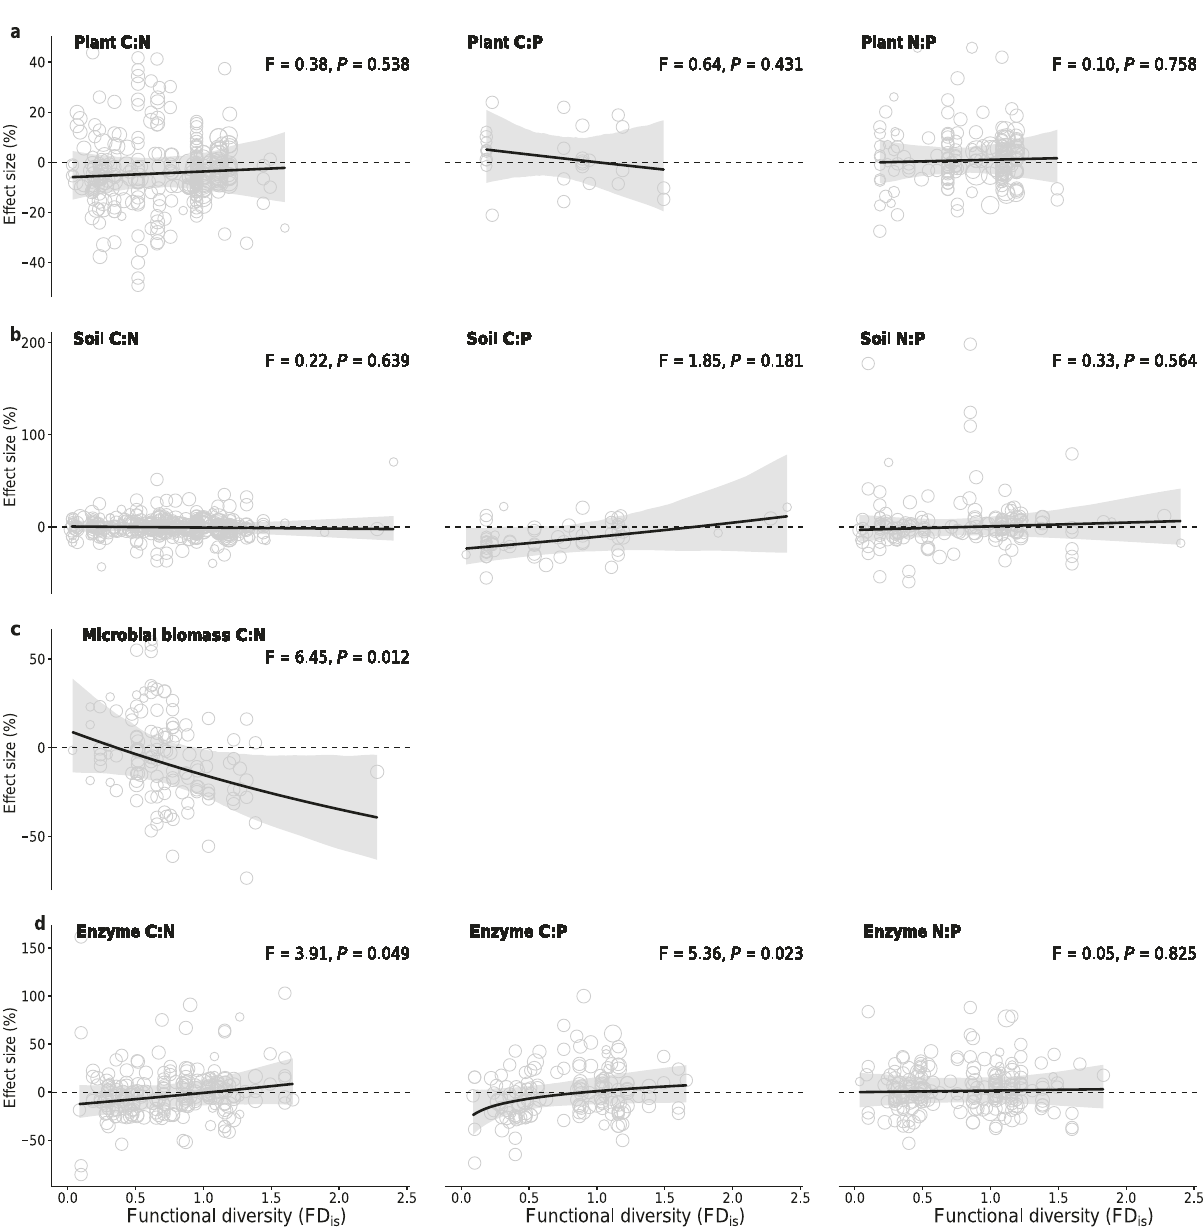
Fig. 3 Comparison of C:N, C:P and N:P ratios of plants, soils, soil microbial biomass, and enzymes in species mixtures versus monocultures in relation to functional diversity. a Plant C:N, C:P, and N:P ratios; b soil C:N, C:P, and N:P ratios; c soil microbial biomass C:N ratio; d soil enzyme C:N, C:P, and N:P ratios. The effects are quanti fi ed as the percent changes in mixtures compared to the corresponding mean value of constituent monocultures. Points represent the values predicted by partial regressions for each explanatory variable, with their sizes representing the relative weights of corresponding observations. Slope estimates are partial dependence, derived from the full model (see “ Methods ” section). Black lines represent the average responses with their bootstrapped 95% con fi dence intervals shaded in